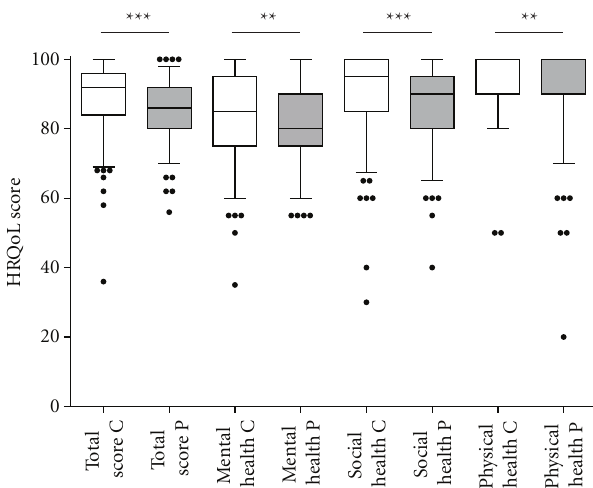
Figure 2: The parents (P, filled boxes) valued their children’s health-related quality of life (HRQoL) as lower than the children themselves did (C, open boxes), both in the total score and in the three domains mental, social, and physical health. Box plot shows the median and 25th and 75th percentiles from 149 child/parents pairs. Error bars represent 10th and 90th percentiles. ∗∗∗ P < 0 . 001; ∗∗ P < 0 . 01.